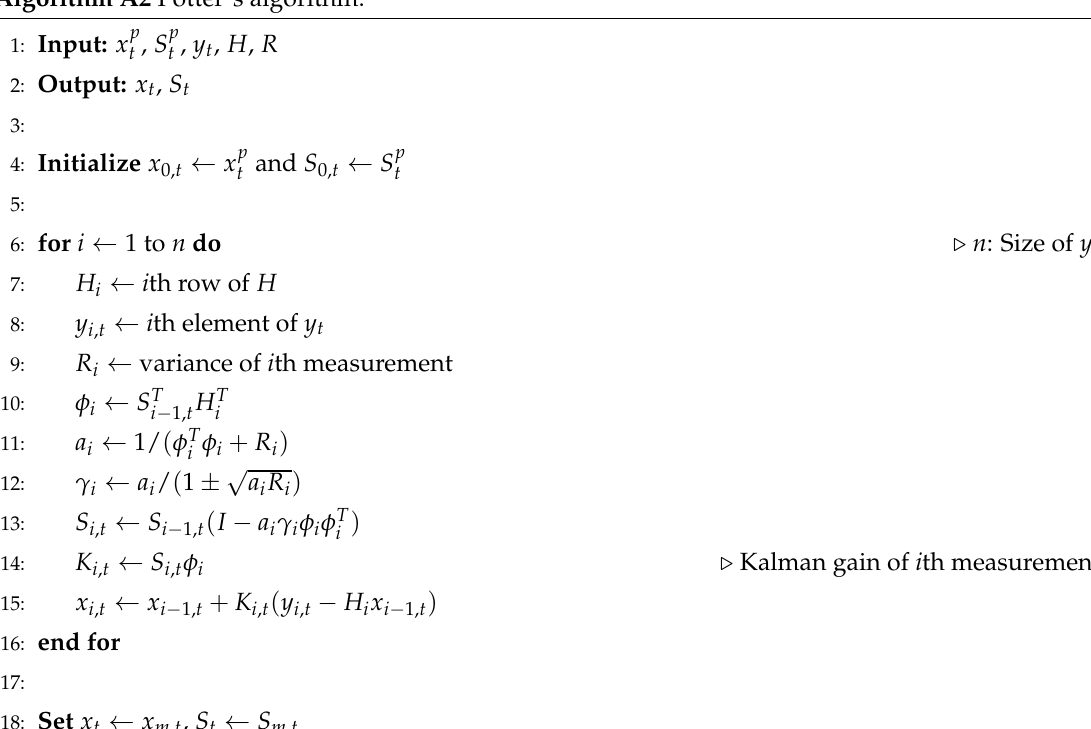
Algorithm A2 Potter’s